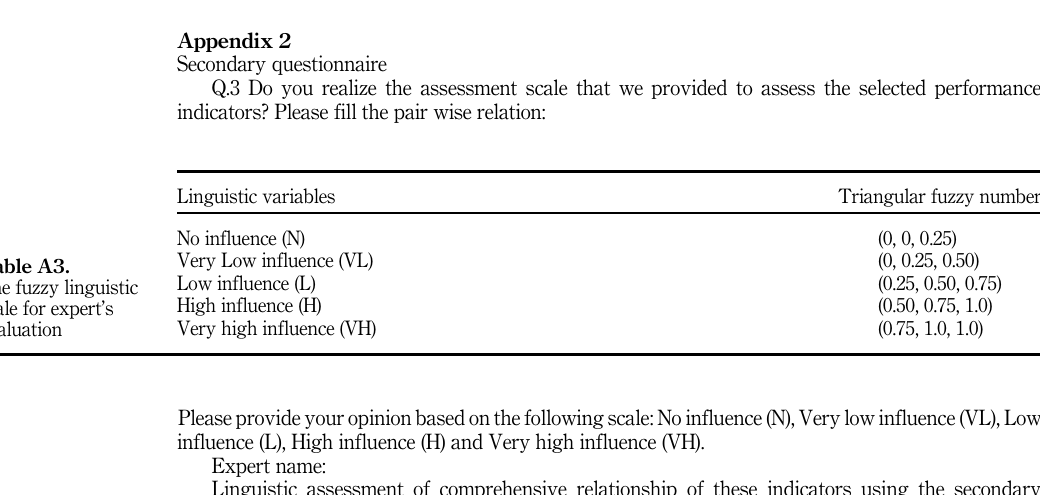
Table A2. Identified the most relevant performance indicators